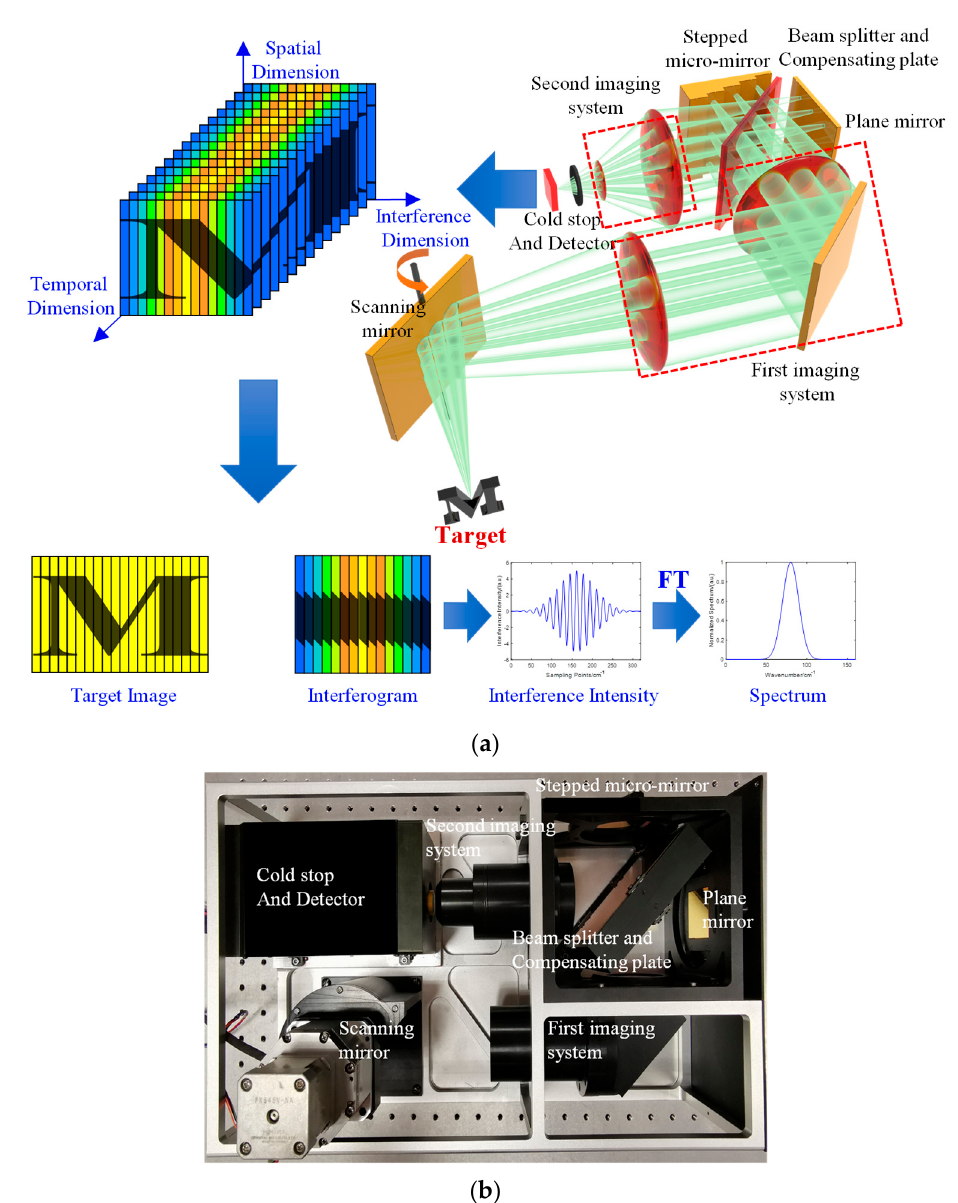
Figure 1. ( a ) Simplified configuration and mechanism for obtaining information about the SIFTS; ( b ) internal structure of the prototype. ( b ) internal structure of the